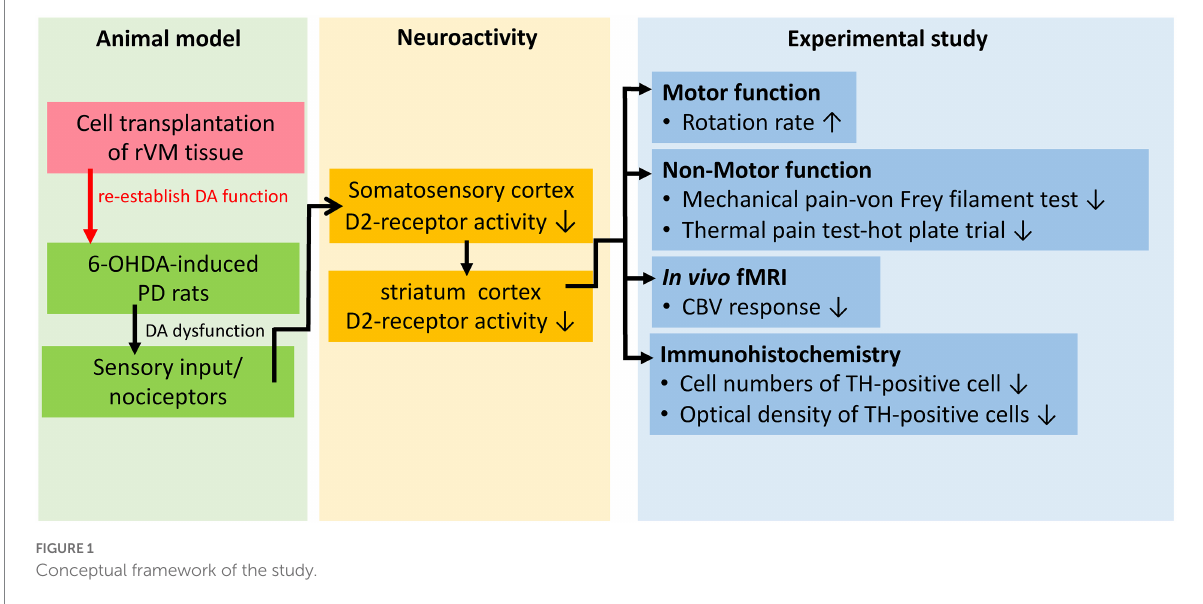
FIGURE 1 Conceptual framework of the study.